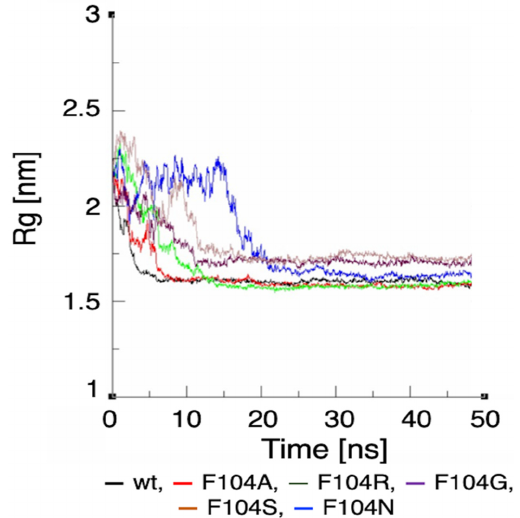
Figure 9. Rg plot showing the effect of FAM72A mutations at AA F104 phenylalanine (F104 → F104A, F104R, F104N, F104G, and F104S) within the FWMF motif (AA101–104) on the dynamic nature of the FAM72A protein and UNG2 (AA1–45) peptide heterodimer binding. We assessed the effect of F104 mutations in FAM72A on the dynamic confirmation changes, stability, and rigidity of core and buried regions. Trajectories recorded up to 50 ns were plotted as RMSD, RMSF, and Rg, respectively. Figures 7–9 show the effect of these mutations on protein backbone changes in mutated FAM72A and signifies the pivotal role of this FWMF motif (AA101–104) for the FAM72A-UNG2 interaction. These data confirm the FWMF motif as a suitable target to interfere with FAM72A-UNG2 signaling pathways.